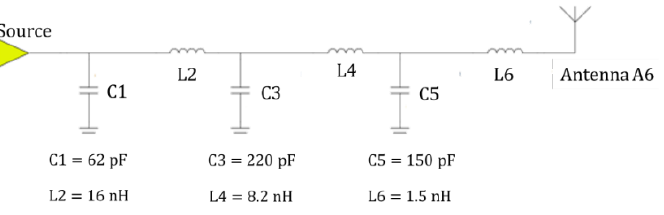
Figure 13. Matching circuit of the miniaturized monopole antenna A5 for the band 118 – 156 MHz.